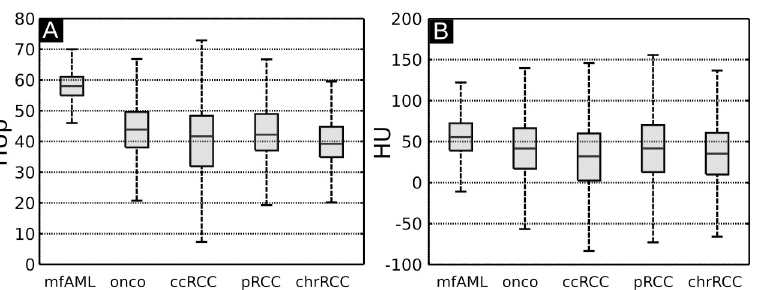
Fig 5. Boxplots of HUp and HU results. Boxplots including all samples of the different tumor subtypes mfAML, oncocytomas (onco), ccRCC, pRCC and chrRCC (n = 26). Mean and standard deviation values for GBPC-CT in HUp (A) and for GBAC-CT in HU (B) are shown here. hfAML samples were excluded for visualization reasons. HU: Hounsfield units, HUp: Hounsfield units phase, mfAML: minimal-fat angiomyolipoma, hfAML: high-fat angiomyolipoma, onco: oncocytoma, ccRCC: clear cell renal cell carcinoma pRCC: papillary renal cell carcinoma, chrRCC: chromophobe renal cell carcinoma, GBPC-CT: grating-based phase-contrast computed tomography, GBAC-CT: grating-based attenuation-contrast computed tomography.